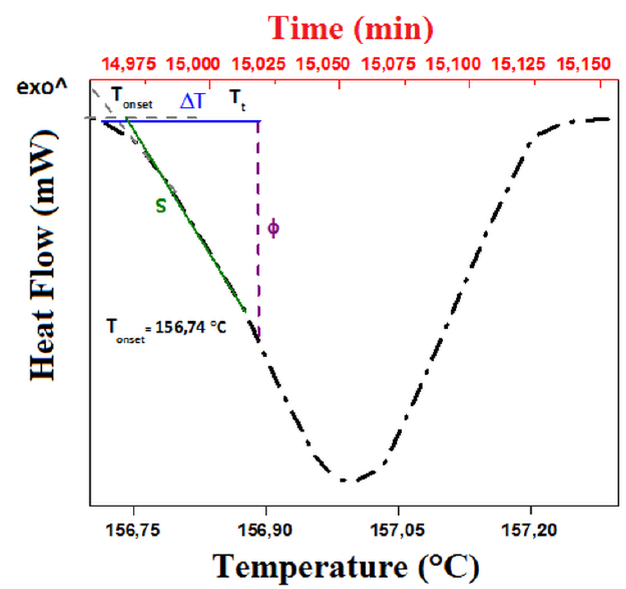
Figure 10. Thermogram recorded in the case of PVP_SiO 2 HT.